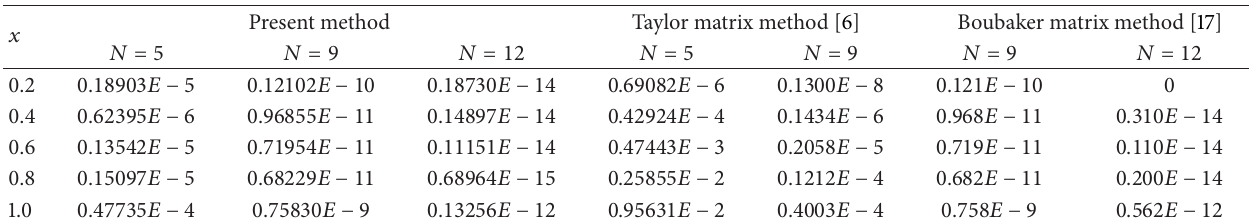
Table 3: Comparison of the absolute errors of different approximation techniques to Example